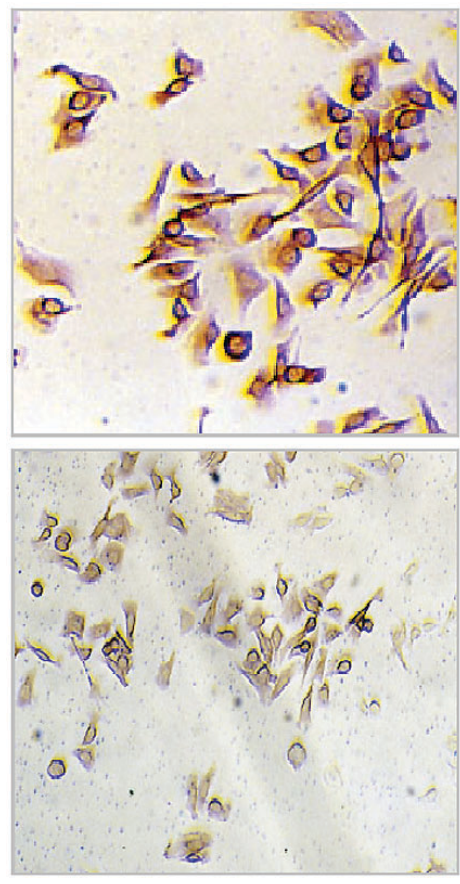
Figure 5. Laminin enhances fo- cal adhesion kinase by thymic epithelial cells. The enzyme is visualized herein by immunocy- tochemistry, and its density is increased when this murine thy- mic epithelial cell line grows on laminin (upper panel), compared to untreated control (bottom panel). Original magnification: